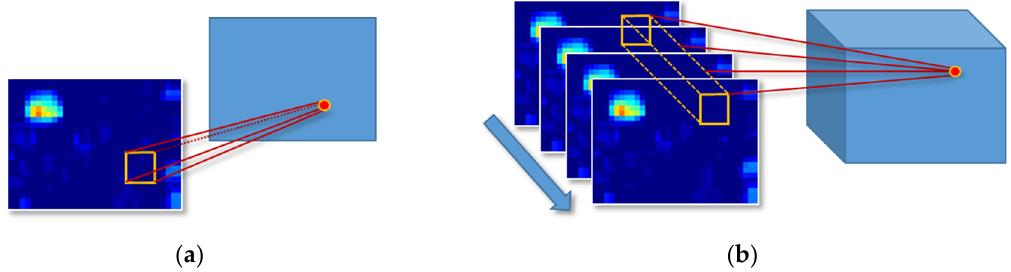
Figure 7. A 2D convolution and a 3D convolution: ( a ) description of the 2D convolutional neural network (CNN); ( b ) description of the 3D CNN.